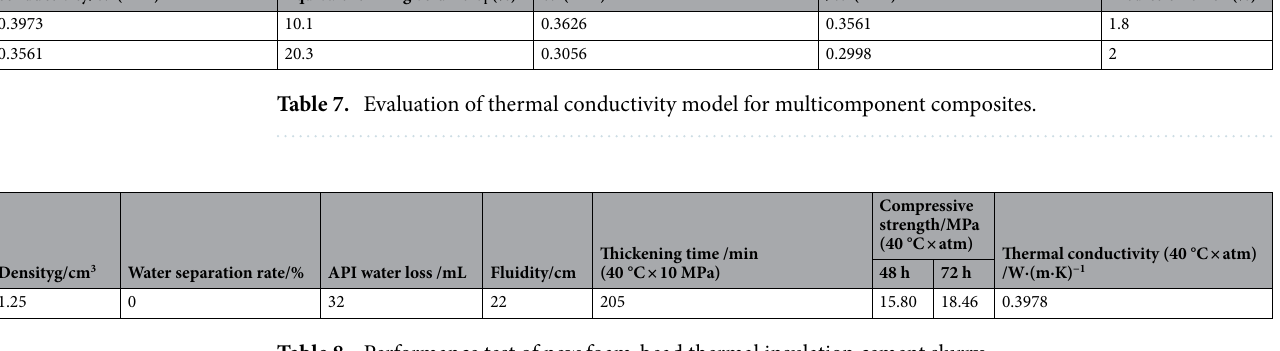
Table 8. Performance test of new foam-bead thermal insulation cement